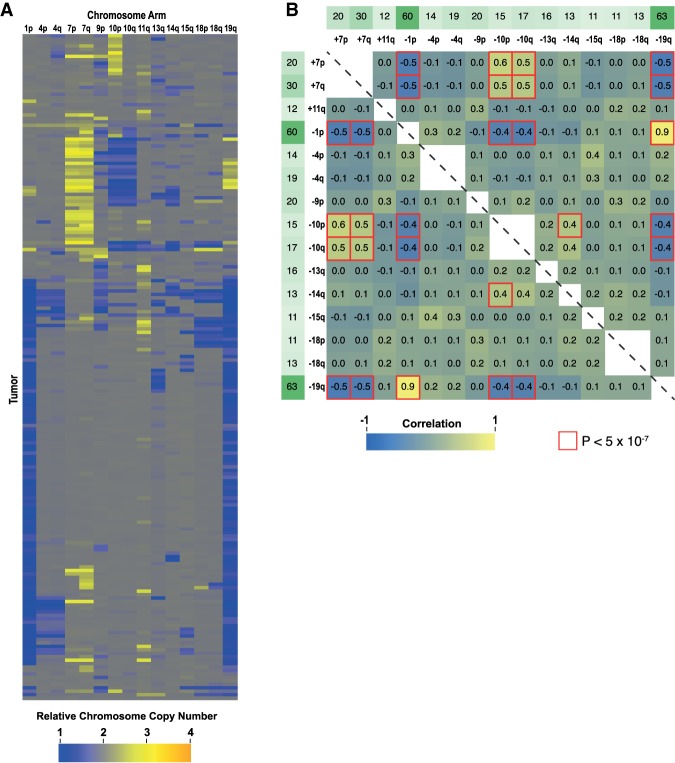
Identification of chromosome copy number correlations in brain LGG tumors. (A) Visualization of the chromosome arm karyotypes from brain LGG tumor samples. Cancer karyotype data was acquired from the CGH data from the TCGA database. Each of the 193 LGG karyotypes is represented as a row, with the column indicating the chromosome copy number of chromosome arms. Only chromosome arms where aneuploidy was present in >10% of the tumor samples are shown. (B) Pairwise correlation coefficients for chromosome arm aneuploidy are shown as a heat map. The frequency of each aberration is shown in green as a percentage. The red highlighted border indicates P < 5 × 10−7 in the hypergeometric test. See Supplemental Figure S4 for similar analysis of four additional tumor types.